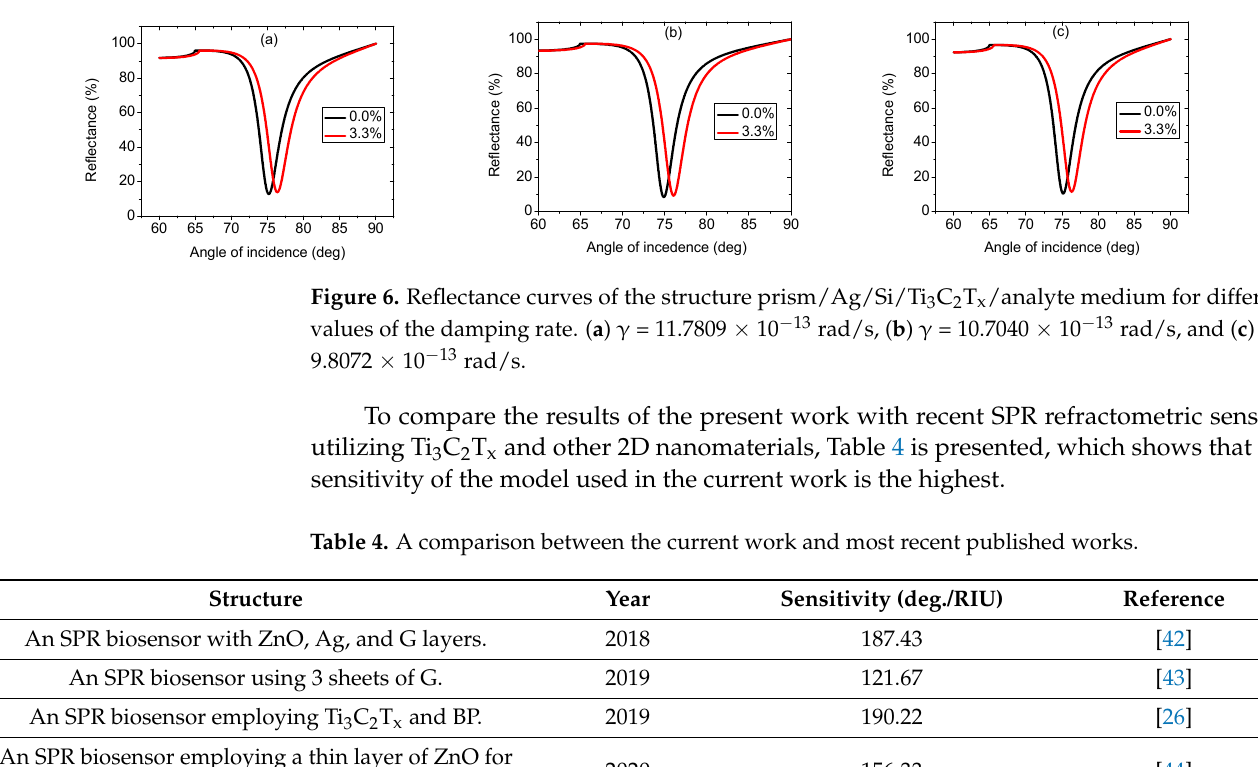
Table 4. A comparison between the current work and most recent published works. Structure Year Sensitivity (deg./RIU) An SPR biosensor with ZnO, Ag, and G layers. An SPR biosensor using 3 sheets of G. An SPR biosensor employing Ti 3 C 2 T x and BP. DNA hybridization. An SPR sensor employing a thin layer of plasma. An SPR biosensor based on